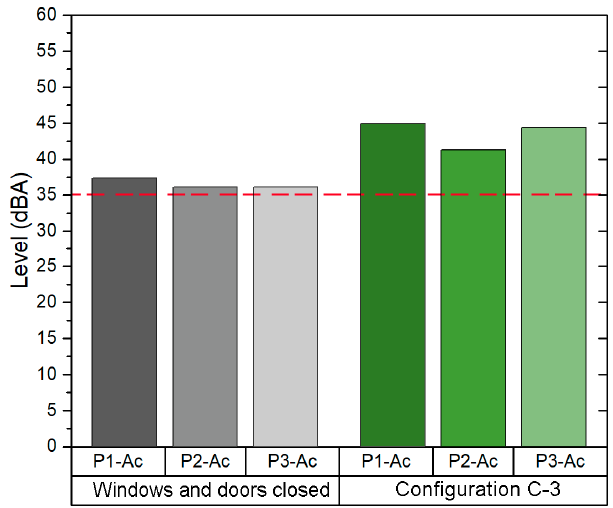
Figure 11. Background noise level in Classroom B2-A1.